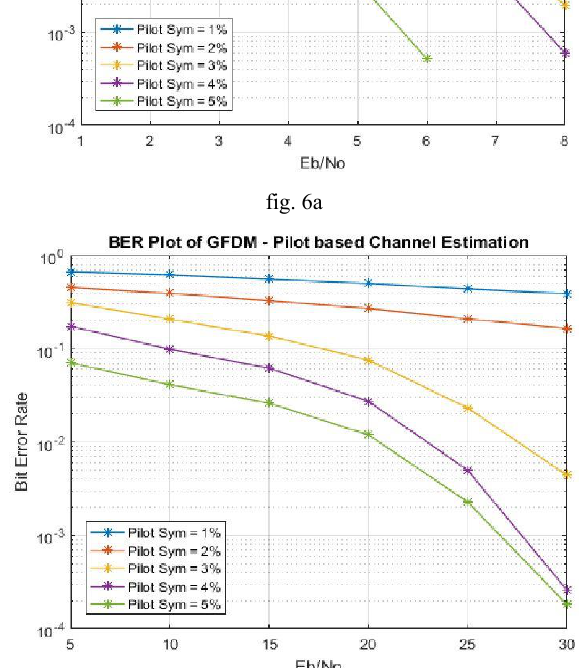
Fig. 6. BER plot when Pilot Symbols are arranged on equal intervals in the data (Method